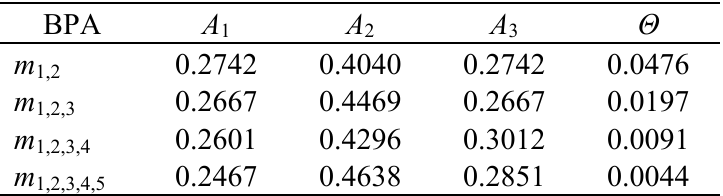
Table 3. Result of decision making.